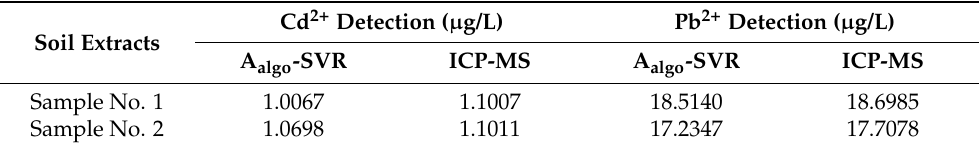
Table 2. Detection results of Cd 2+ and Pb 2+ concentrations in soil extract solutions. Cd 2+ Detection ( µ g/L) Pb 2+ Detection ( µ g/L) Soil Extracts A algo -SVR ICP-MS A algo -SVR ICP-MS Sample No. 1 1.0067 1.1007 18.5140 Sample No.